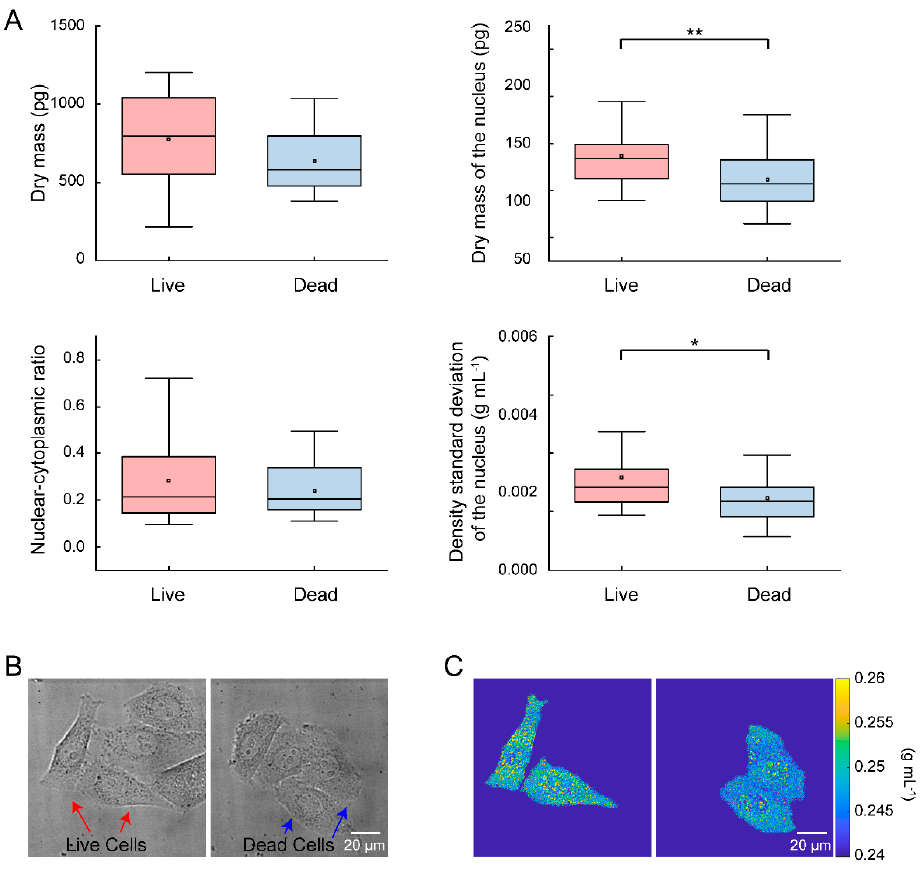
Figure 4. The relationship between cell heterogeneity and chemotherapeutic efficacy for single HeLa cells. ( A ) The dry mass, dry mass of the nucleus, nuclear–cytoplasmic ratio and density standard deviation of the nucleus for 150 living single cells and 149 dead single cells. ** p < 0.01, * p < 0.05. ( B ) Imaging results with DIC microscopy before dosing. The red arrow indicates the living cells, and the blue arrow indicates the dead cells. ( C ) Imaging reconstruction results before dosing with